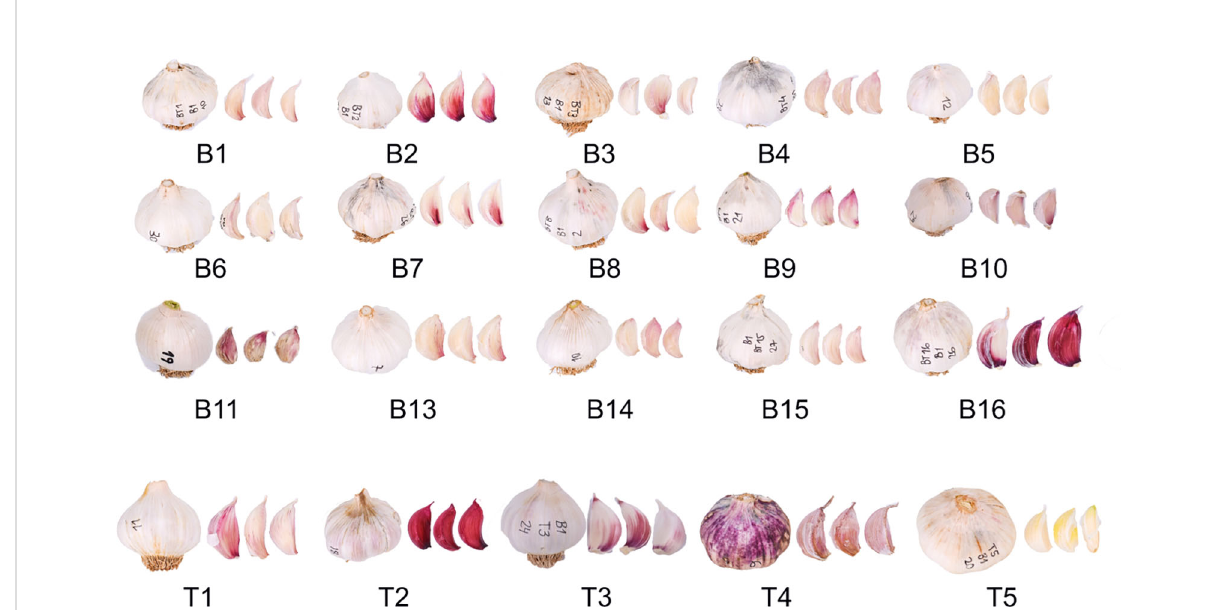
FIGURE 1 Plant materials used in this study. B1-B16 correspond to the local Belltall garlic populations collected among farmers of the traditional area of cultivation. T1-T5 correspond to the controls. Images show representative garlic bulbs and cloves for each